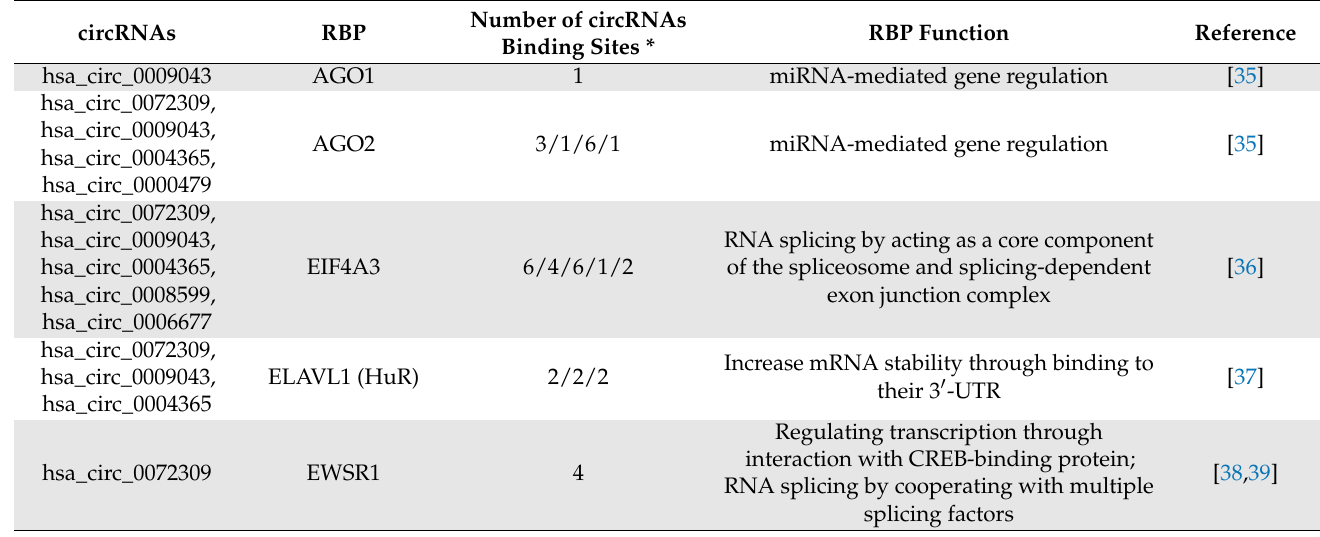
Table 3. RBPs predicted to bind in the studied circRNAs and their described